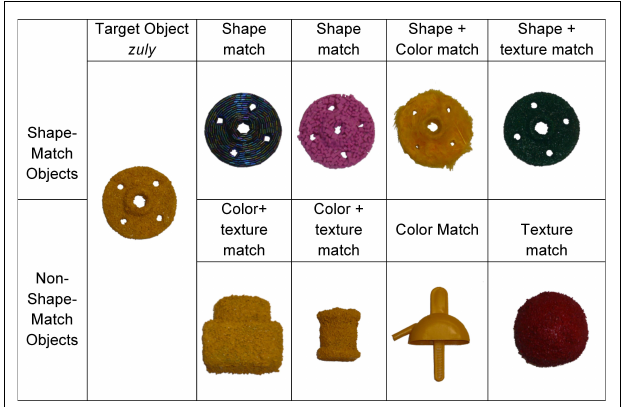
FIGURE 1 | One of the sets of stimuli used in Experiment 1 and Experiment 2. All sets had the same similarity